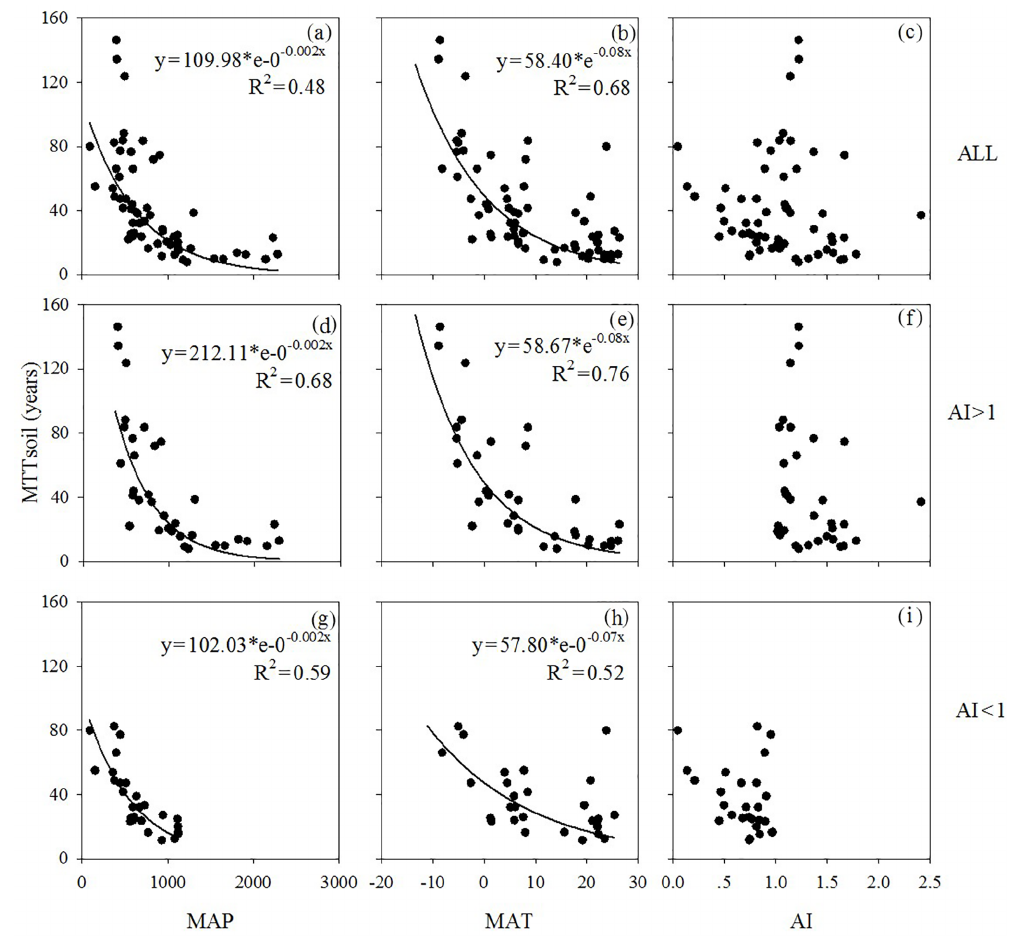
Figure 5. Relationships between soil mean turnover time (MTT soil ) and multi-annual temperature (MAT, b, e, h ) or precipitation (MAP, a, d, g ) at different aridity indexes (AI, c, f, i ). Each data point stands for average values of each biome. Biomes were assigned into 62 types according to land cover and three temperature